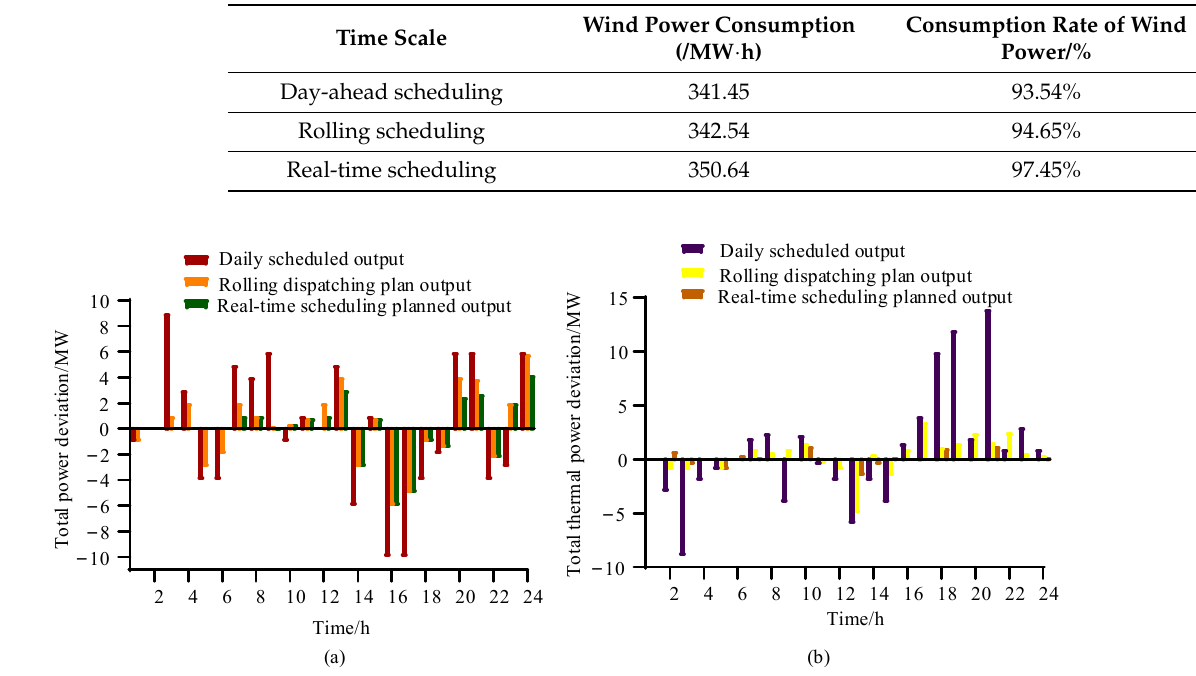
Figure A4. The deviation results of total electric power and longitudinal thermal power of the system at different time scales ( a ). Total electric power deviation results in each period, ( b ). Total thermal power deviation results in each period.